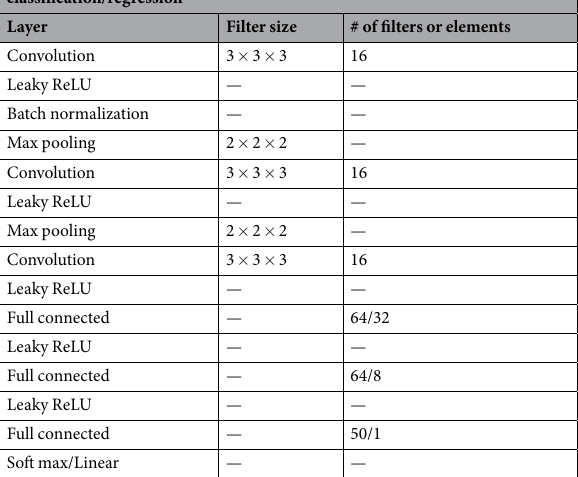
— Table 1. Architectures of the CNNs for the classification and regression in this